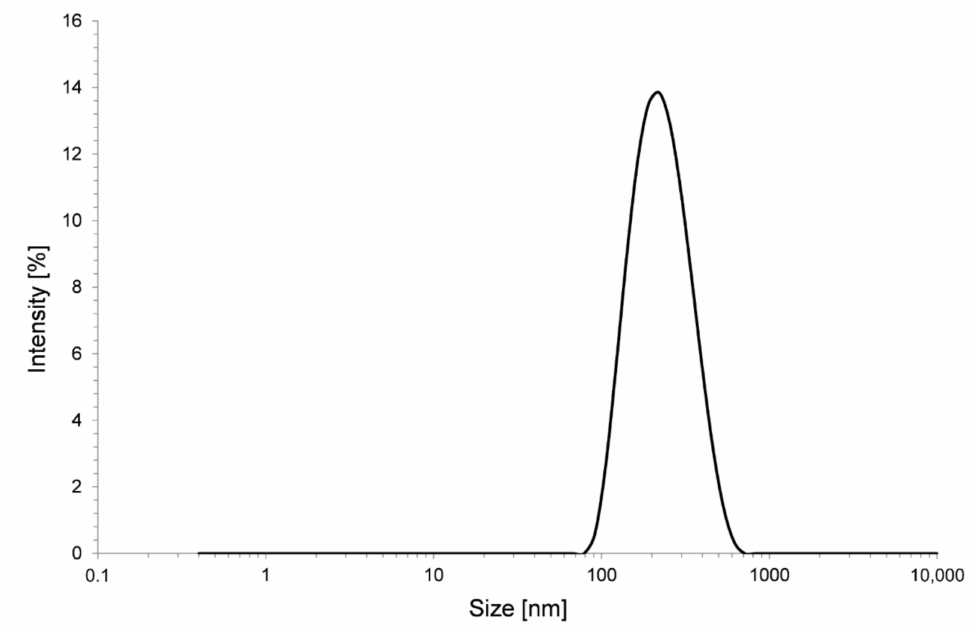
Figure 2. DLS spectrum showing the particle size distribution in the silica.